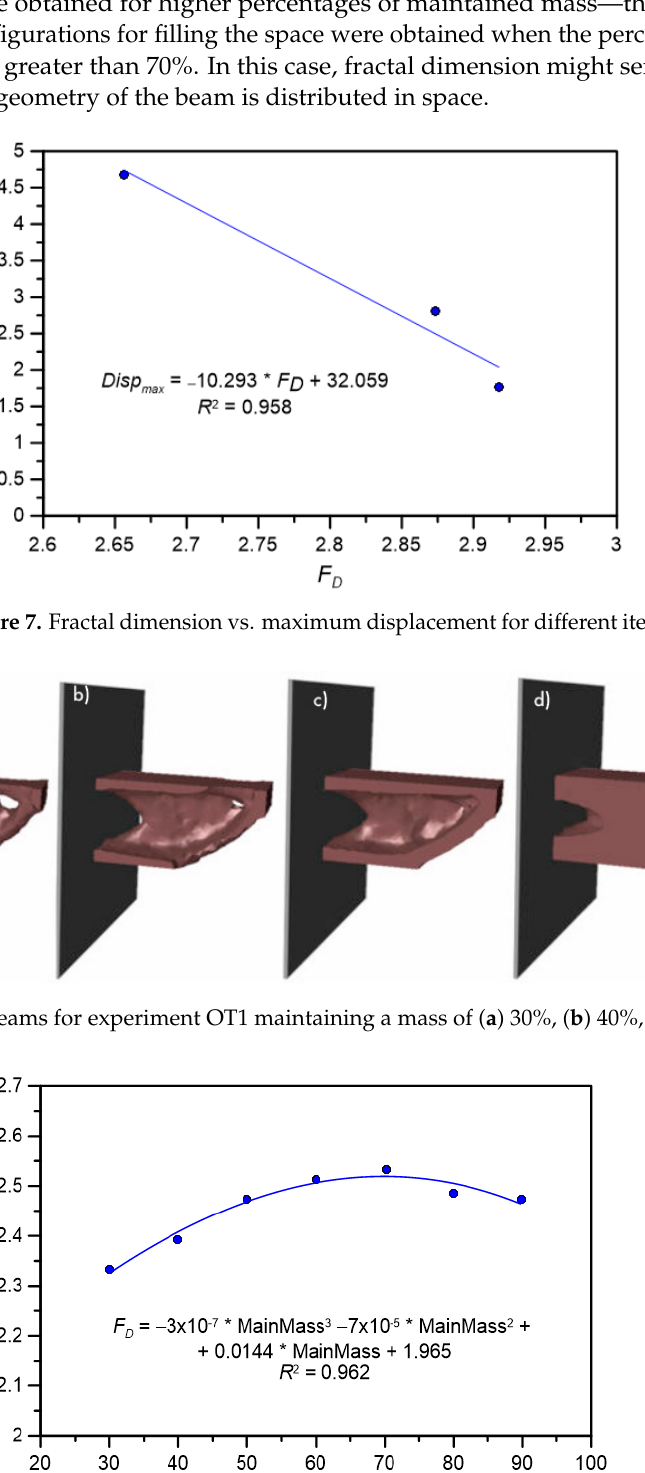
Figure 8. Representation of beams for experiment OT1 maintaining a mass of ( a ) 30%, ( b ) 40%, ( c ) 50% and ( d ) 70%. Figure 9. Maintained mass vs. fractal dimension for experiment OT1. Figure 9. Maintained mass vs. fractal dimension for experiment